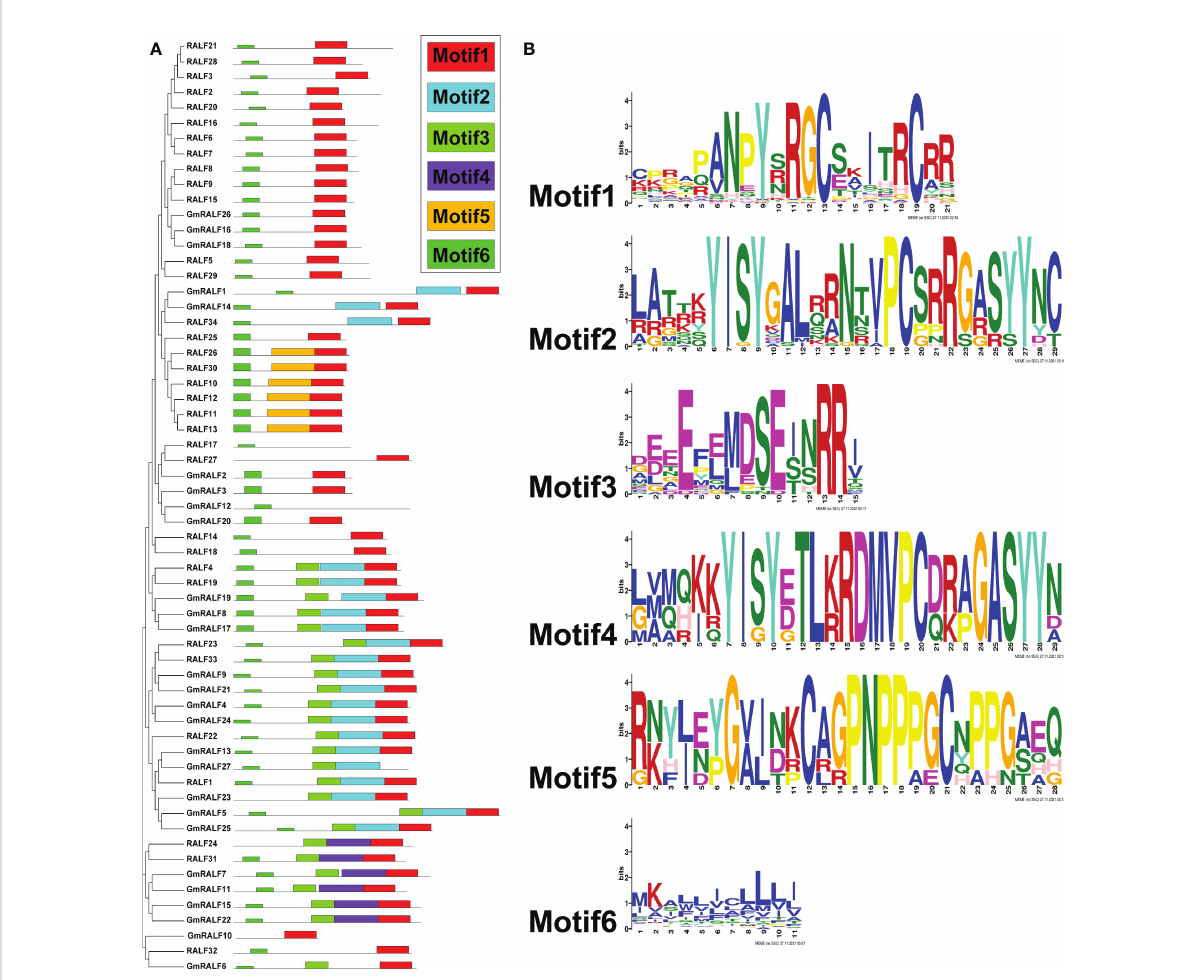
FIGURE 3 Phylogenetic clustering, the motif patterns and the six motifs of the RALF members in soybean and Arabidopsis . (A) Phylogenetic clustering and motif patterns of the GmRALF members. The six distinct MEME motifs were displayed in different colored boxes. (B) The six motifs in the